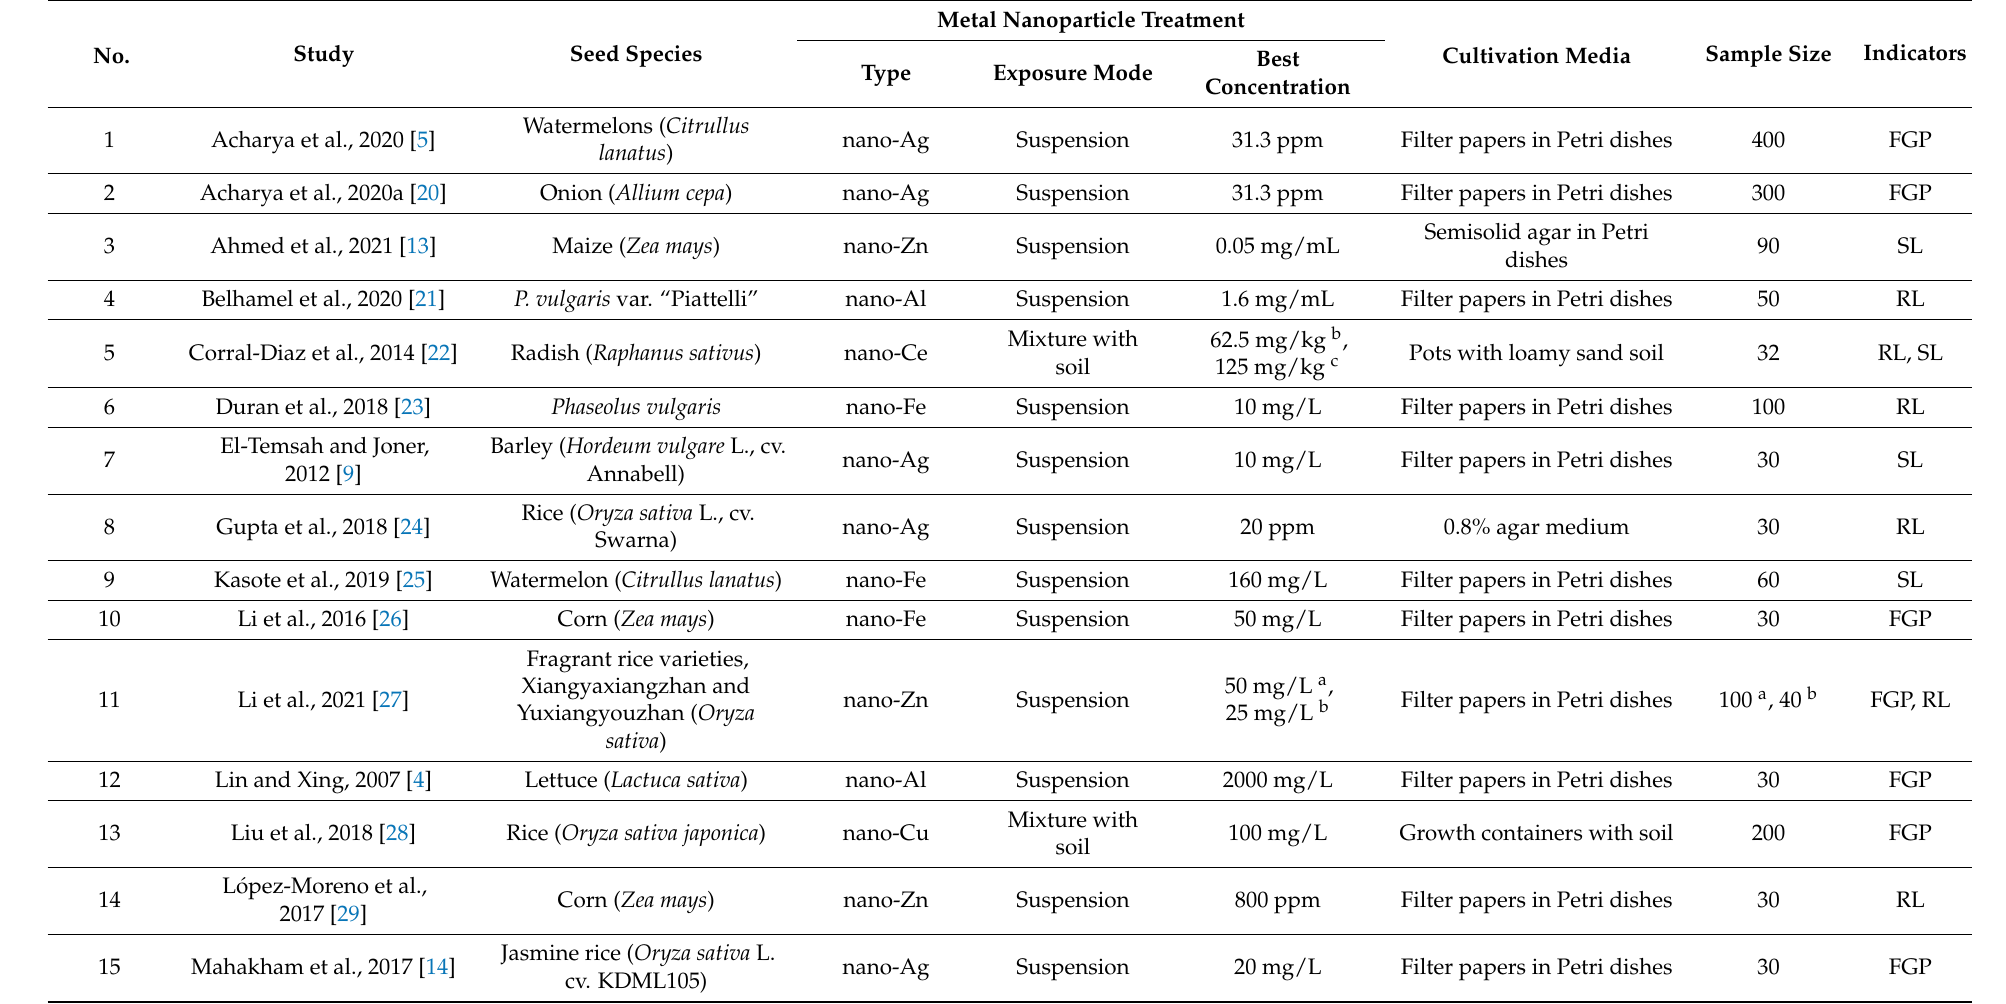
Table 1. Literature review of the studies included in the